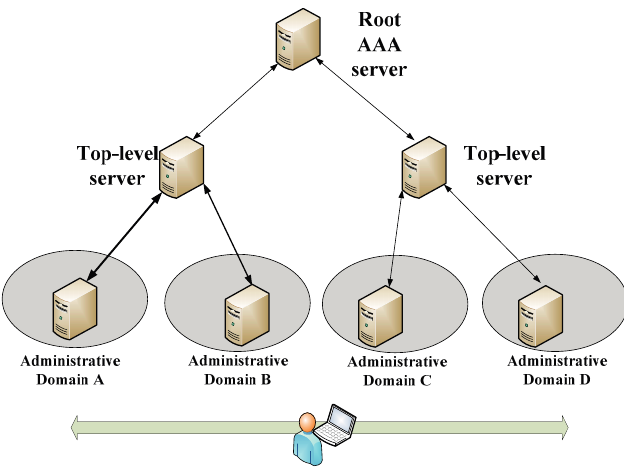
Figure 2. EduRoam tree-like interconnection of AAA servers with different administrative domains. Problem